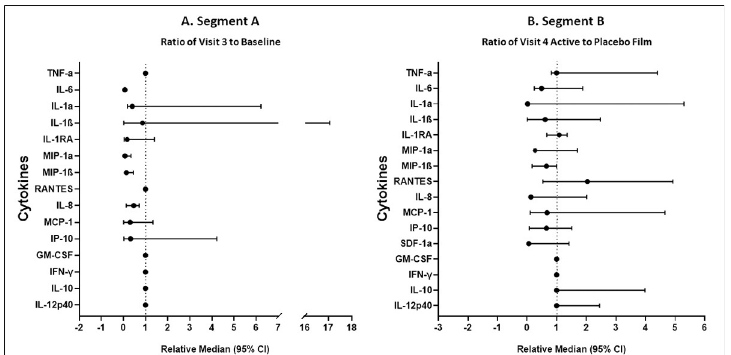
Fig 6. Forest plots of cytokines in CVLs: ( A). The ratio (relative median ± 95% confidence interval) of Visit 3 (24 hours after single film) to Baseline concentrations in Segment A, and ( B). The ratio (relative median ± 95% confidence interval) of Active film Visit 4 (24 hours after seventh film) to Placebo film Visit 4 concentrations in Segment B. No significant increases in cytokine concentrations were observed following Active film insertion or in Active film vs. Placebo film group